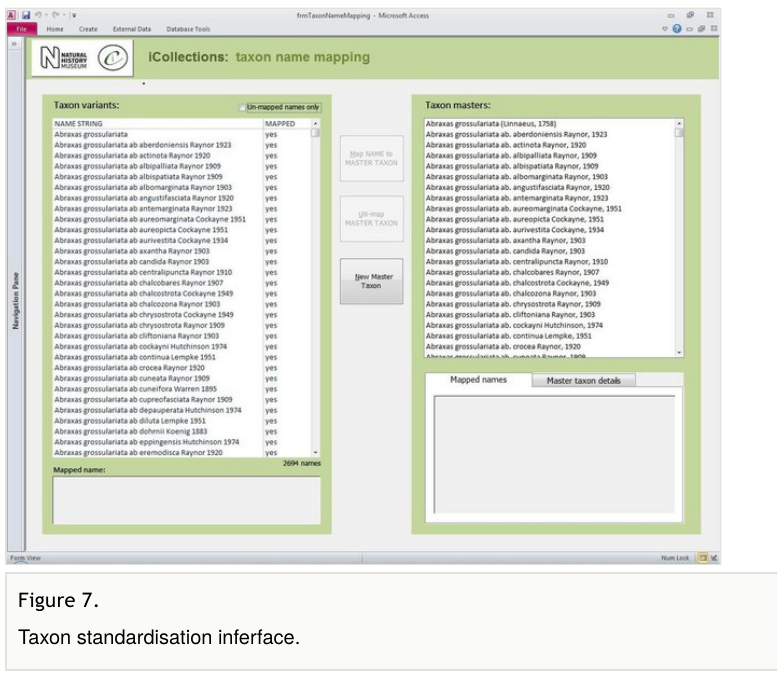
Figure 7. Taxon standardisation inferface.